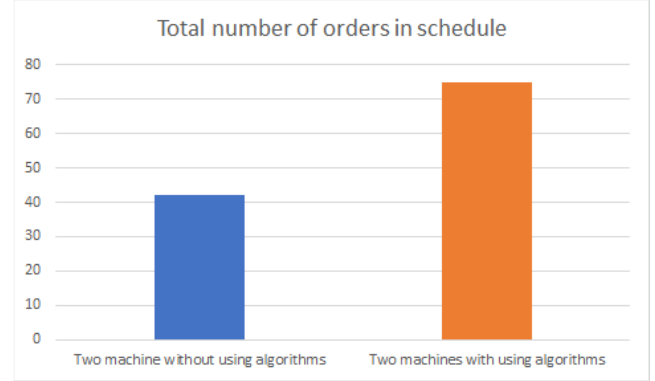
Table 5. The overall performance of the total number of orders and total setup time used in the schedule.